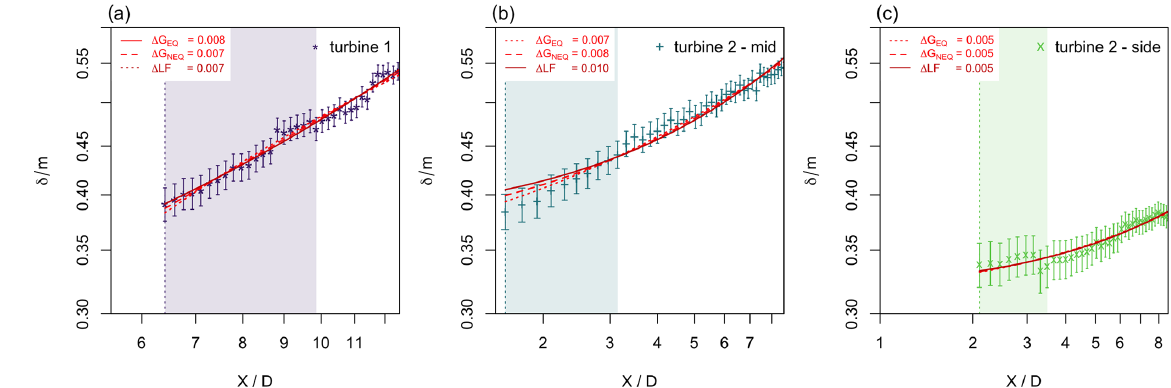
Figure 12. δ ( X/D ) for the three different inflow conditions: (a) turbine 1 – laminar inflow, (b) turbine 2 mid – turbulent, and (c) turbine 2 side – turbulent and intermittent. The EQ and NEQ models and a linear fit are applied. Note that the axes are logarithmic.